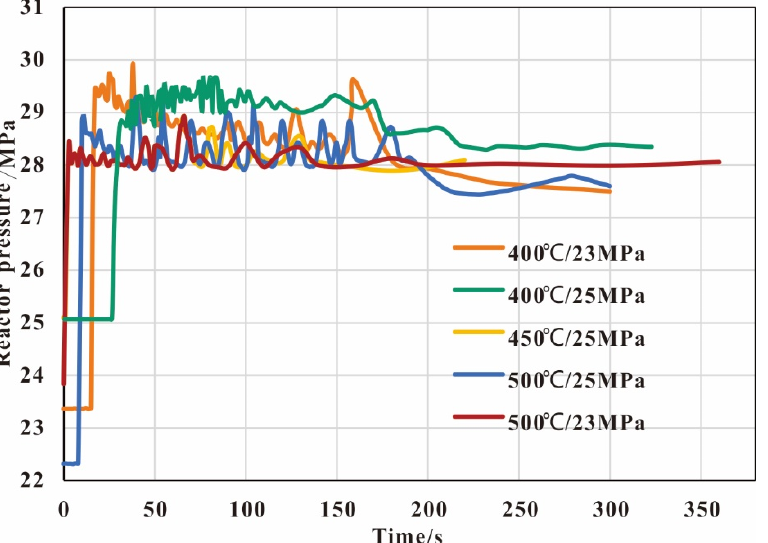
Figure 10. Pressure changes in the reactor during the experiment of supercritical water–diesel reac- tions under different initial temperature and pressure conditions.